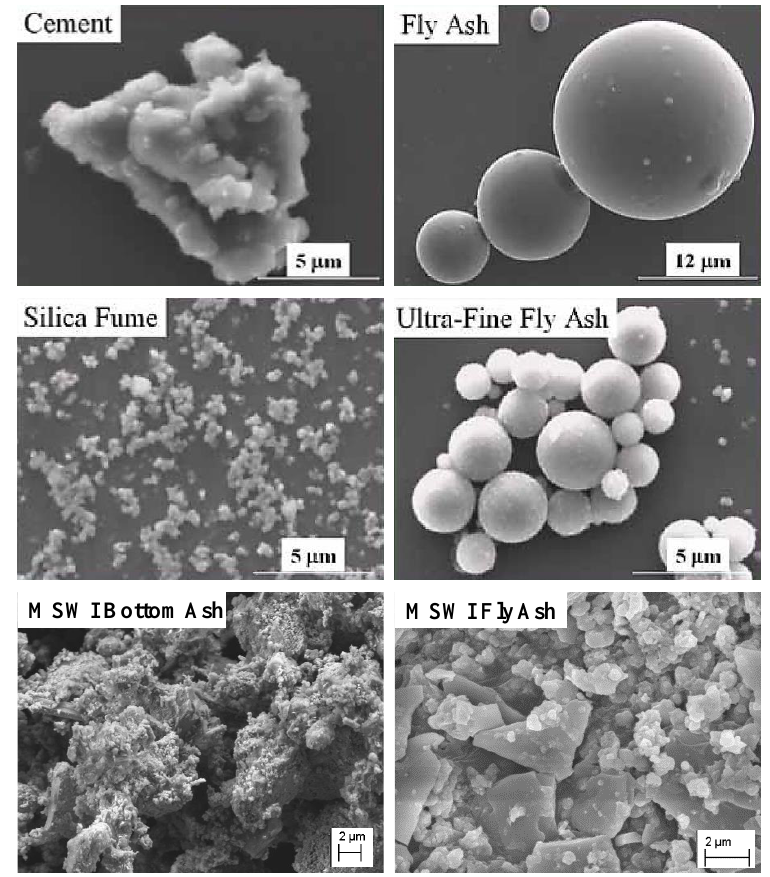
Figure 4. SEM images of MSWI BA, MSWI FA, and SCMs [130].